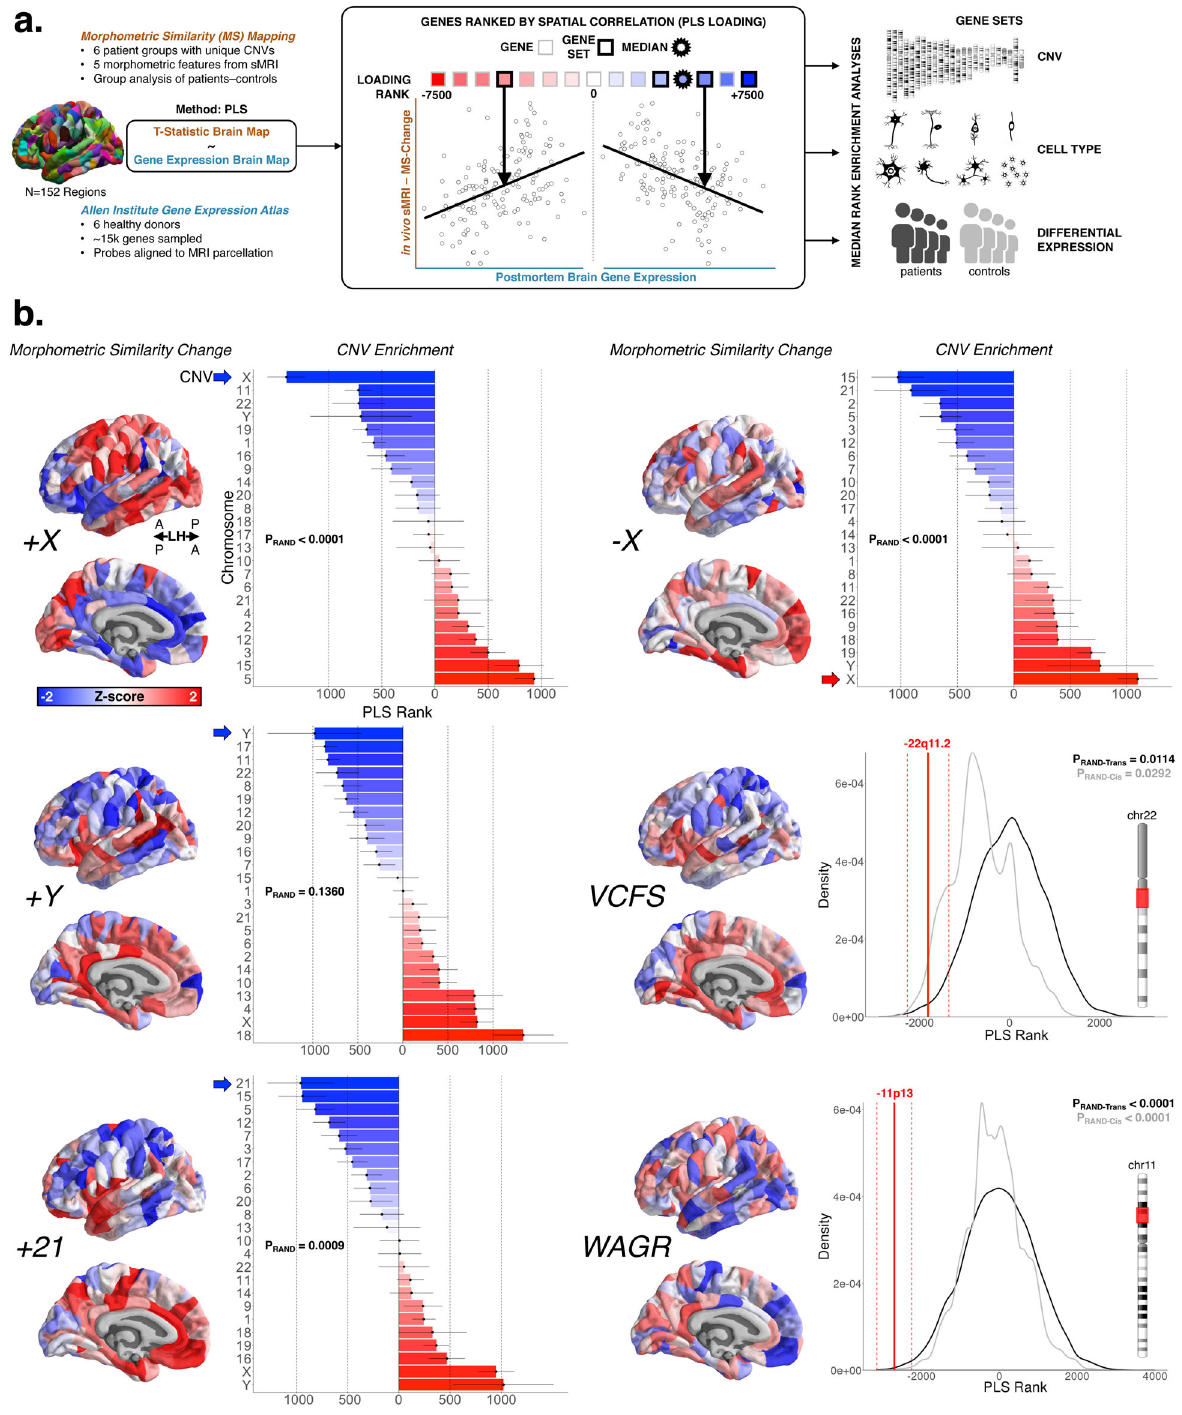
The correct version of Fig. 1